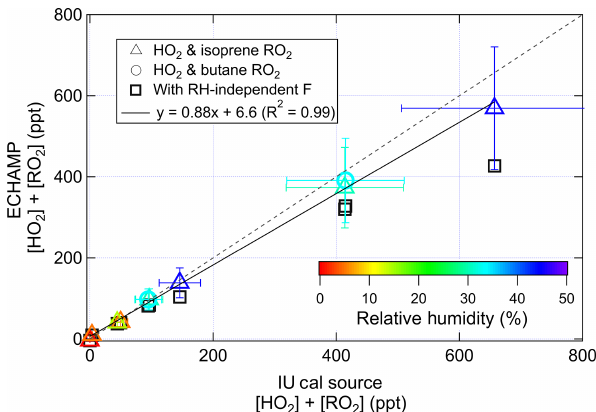
Figure 2. Results of the calibration comparison in which ECHAMP measured the total peroxy radical concentration in the output of the IU calibration source. The error bars indicate 2 σ uncertainties of the ECHAMP measurements and IU calibration source, adjusted for the fact that the IU actinometry was based on the ECHAMP NO 2 calibration. The slope of the dotted line is